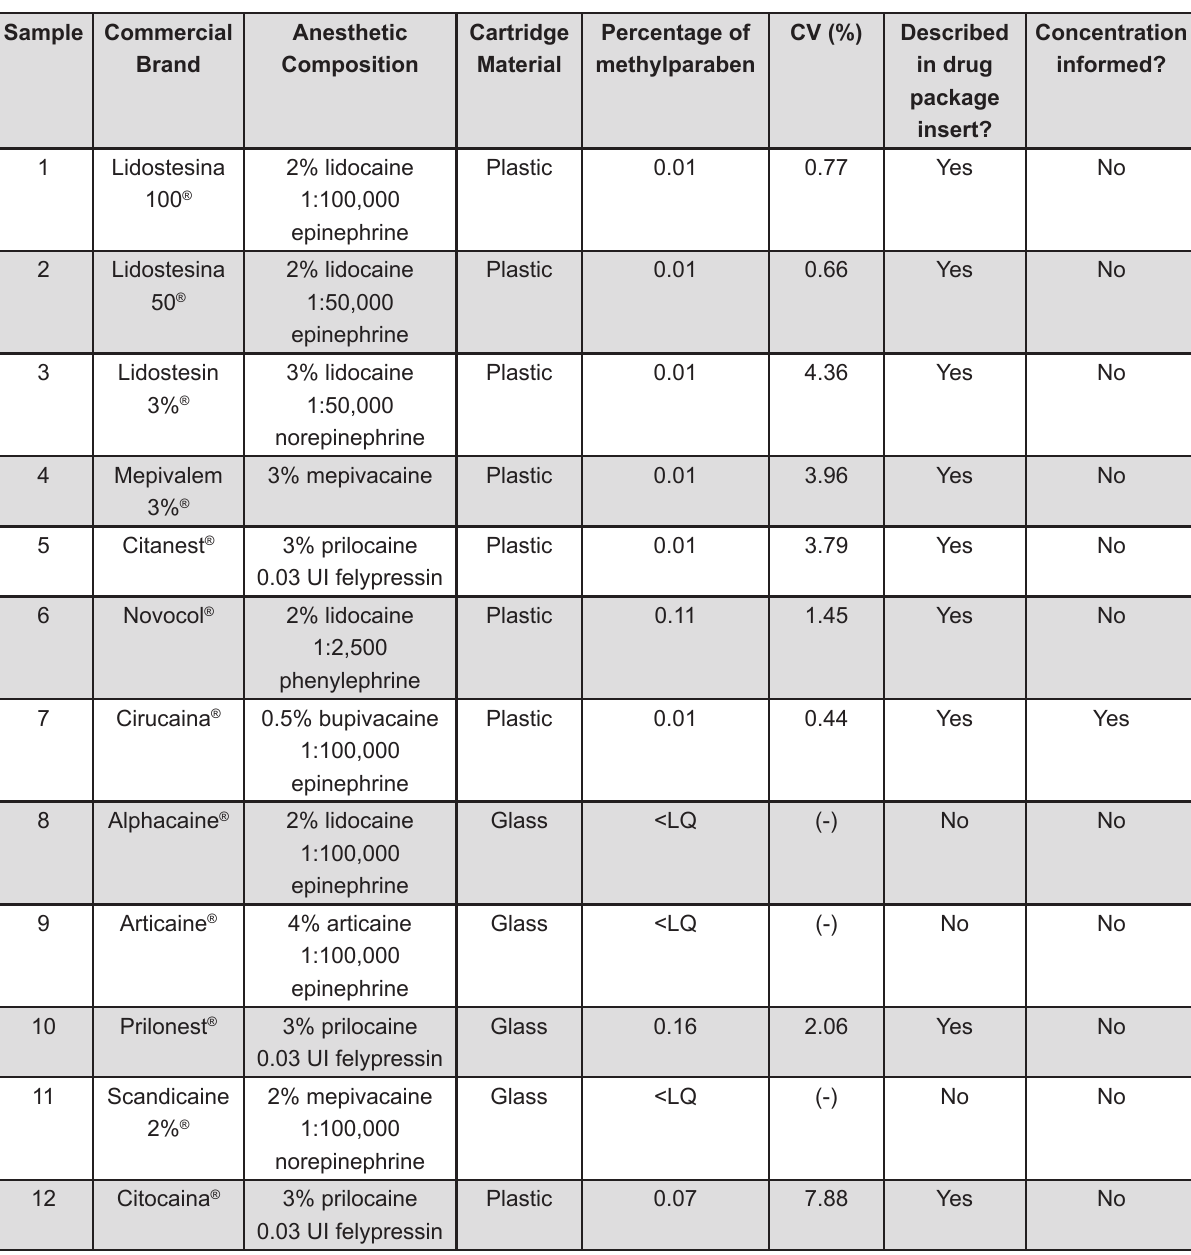
Figure 1- Concentration of methylparaben in different cartridges available on the Brazilian